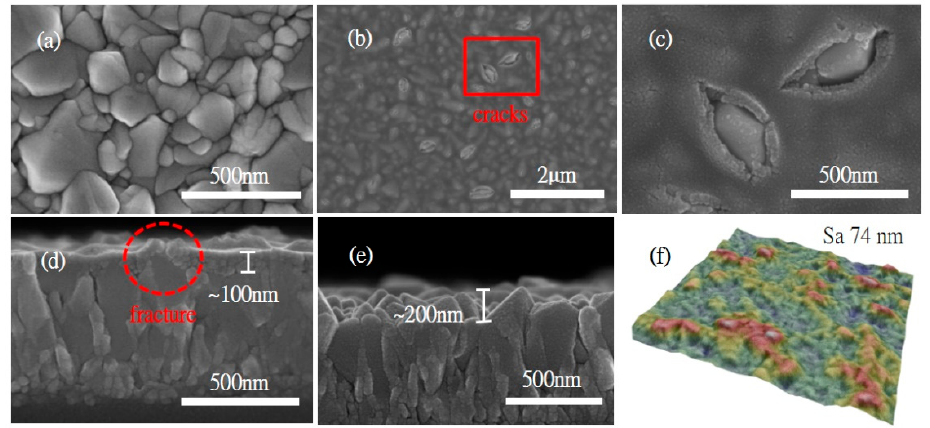
Figure 1. SEM images: ( a ) Top ‐ view SEM image of bare FTO glass; ( b , c ) Top ‐ view SEM image of TiO 2 film; ( d ) Cross ‐ sectional SEM image of TiO 2 film; ( e ) Cross ‐ sectional SEM image of bare FTO glass; ( f ) Top ‐ view SEM image of 3D roughness reconstruction of bare FTO glass.